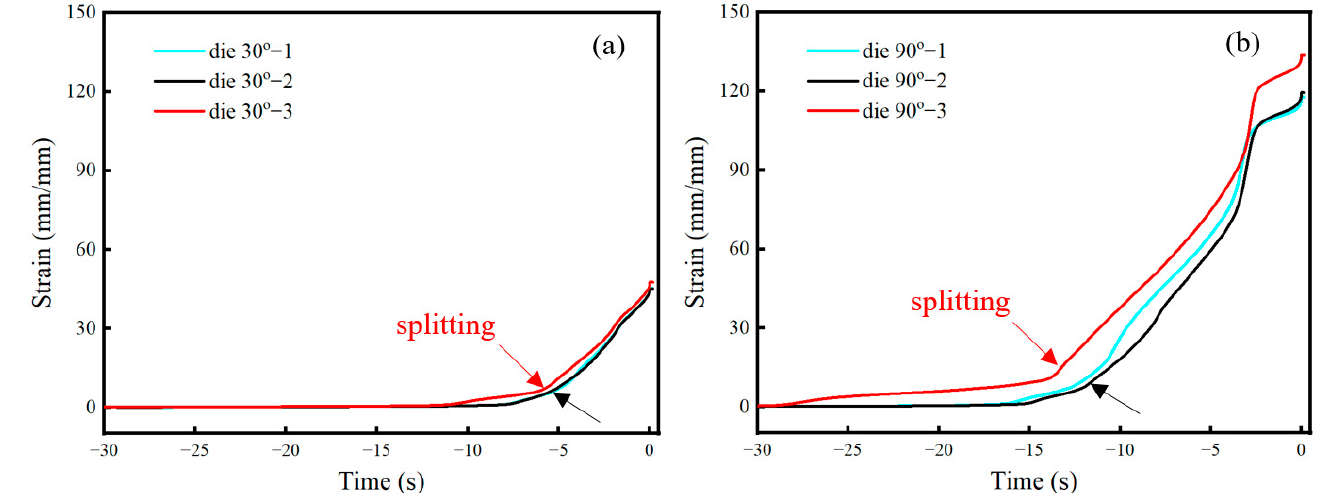
Figure 20. Model predicted strain history of the weld seam material and how it is impacted by the upper bridge’s geometry: ( a ) die 30° series and ( b ) die 90° series.